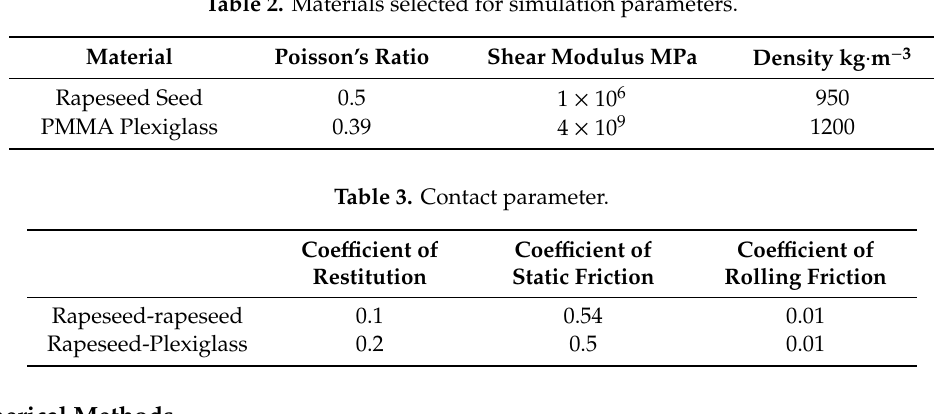
Table 2. Materials selected for simulation parameters.